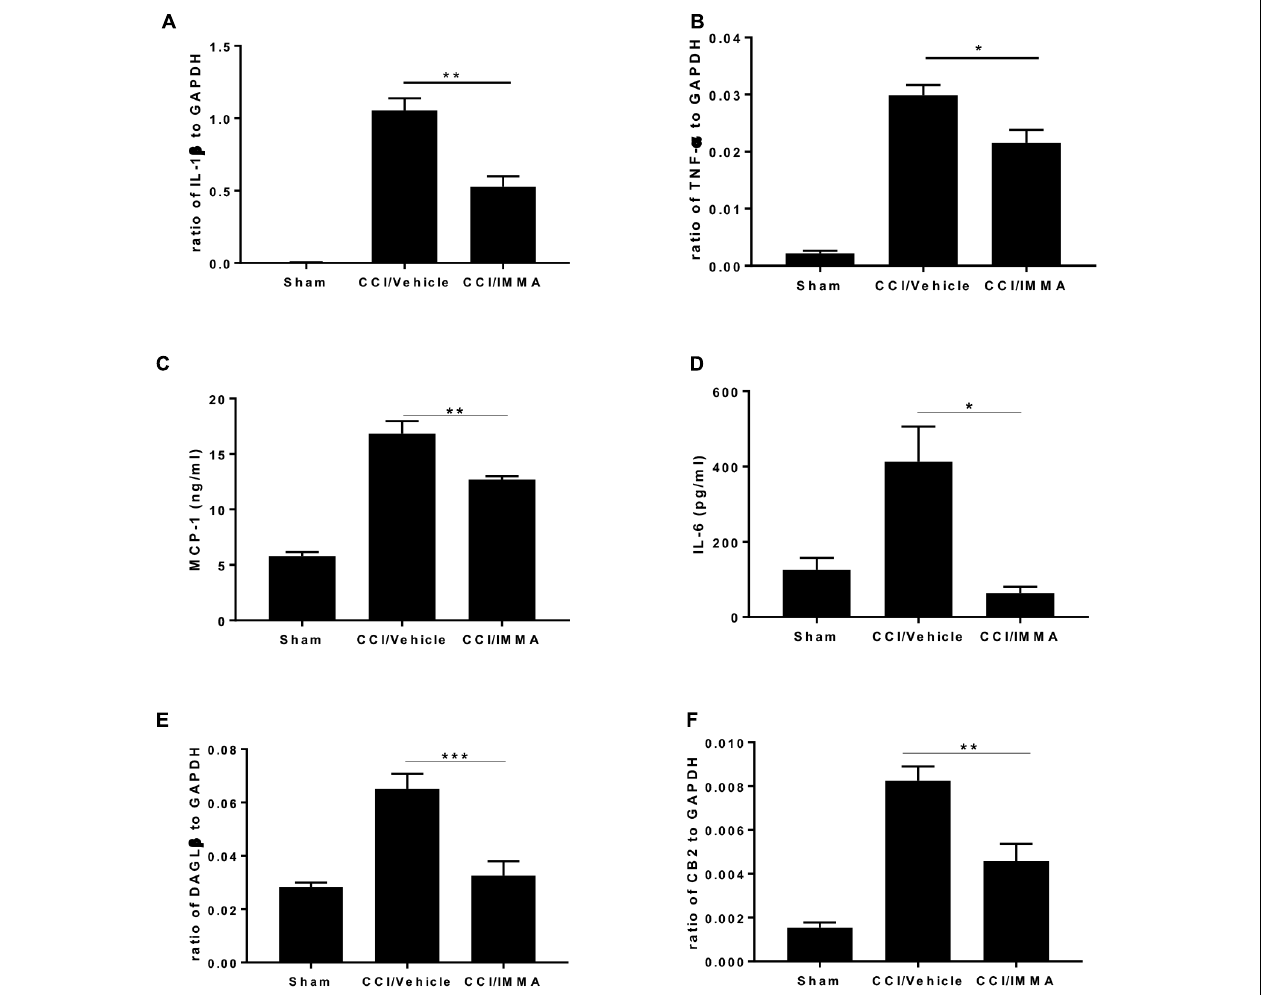
FIGURE 4 | . IMMA treatment attenuated the production of proinflammatory cytokines and chemokines in the ipsilateral sciatic nerve of CCI mouse. The fresh sciatic nerves from mice 7 days post-surgery were subjected to qRT-PCR analysis and ELISA. The remarkably increased IL-1 β (A) , TNF- α (B) , DAGL β (E) , and CB2R (F) expression was observed in the CCI/vehicle group and reduced by IMMA treatment. Protein levels of MCP-1 (C) and IL-6 (D) in the ipsilateral sciatic nerve 7 days post-surgery were significantly elevated by CCI and inhibited by IMMA treatment ( ∗ p < 0.05, ∗∗ p < 0.01; and ∗∗∗ p < 0.001. n = 10/group). One-way ANOVA was used for comparing the differences among the sham, vehicle and IMMA treated groups. The Tukey-Kramer post hoc test was used for the